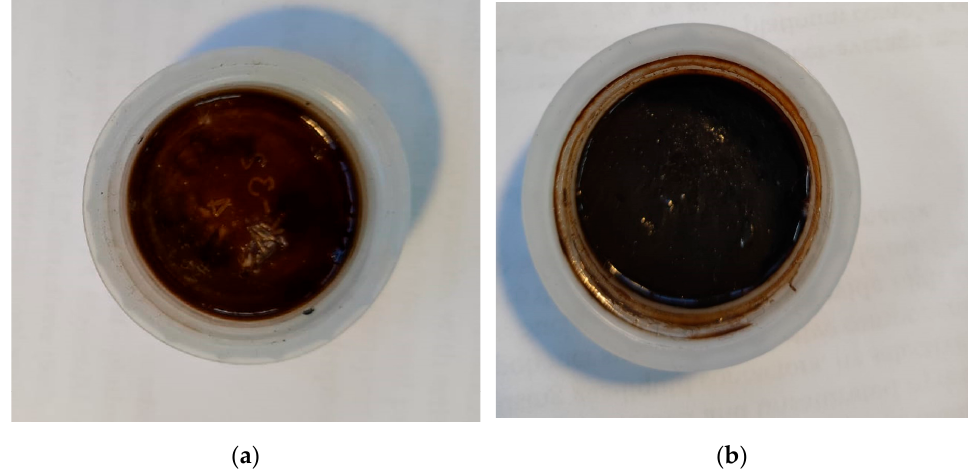
Figure 4. Types of POMS polymer films with the addition of AgBF 4 : ( а ) 1 wt%, ( b ) 20 wt%.